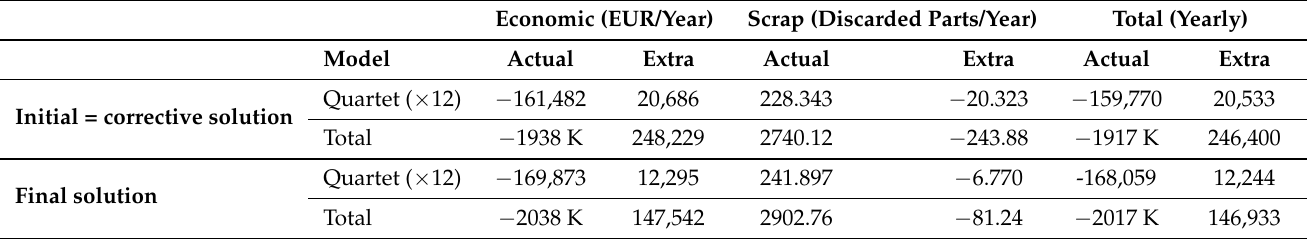
Table 8. Total KPIs with respect to components with summation for the whole production line, yielded from training the model for GORENJE.